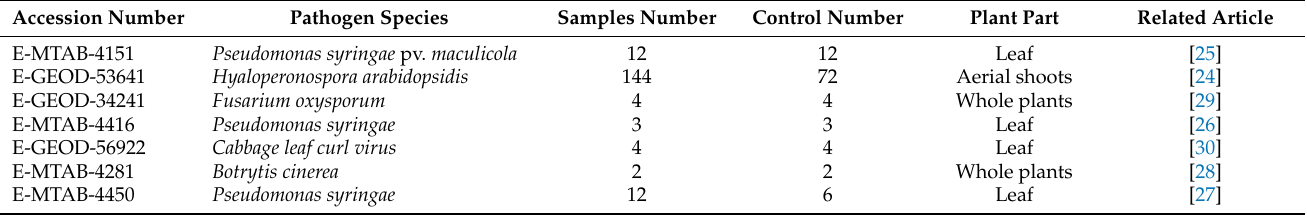
Table 1. Transcriptomic raw data related to plant–pathogen interaction studies of Arabidopsis thaliana used for the current meta-analysis.